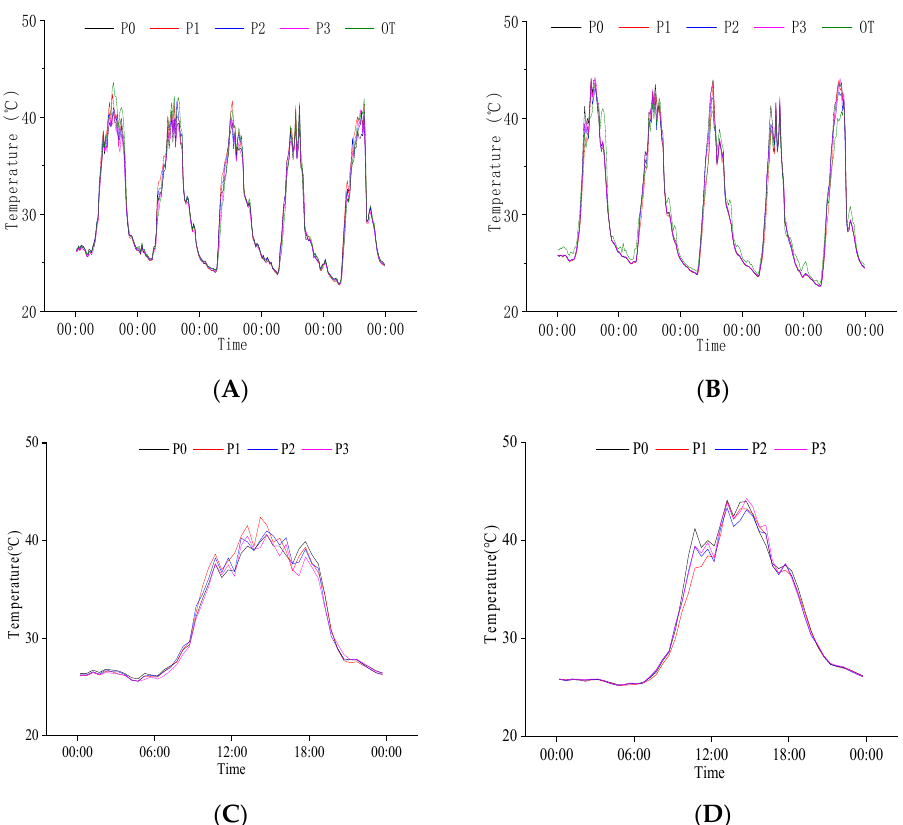
Figure 6. Variation in population temperature at heading stage. ( A ) Canopy population temperature from 26 July to 30 July; ( B ) Baselayer temperature of the population from 26 July to 30 July; ( C ) Canopy temperature of the population on 26 July; ( D ) Baselayer temperature of the population on 26 July. OT is the change in external temperature, P0, P1, P2, and P3 are the effects of different nitrogen fertilizers on population temperature under N1 conditions.